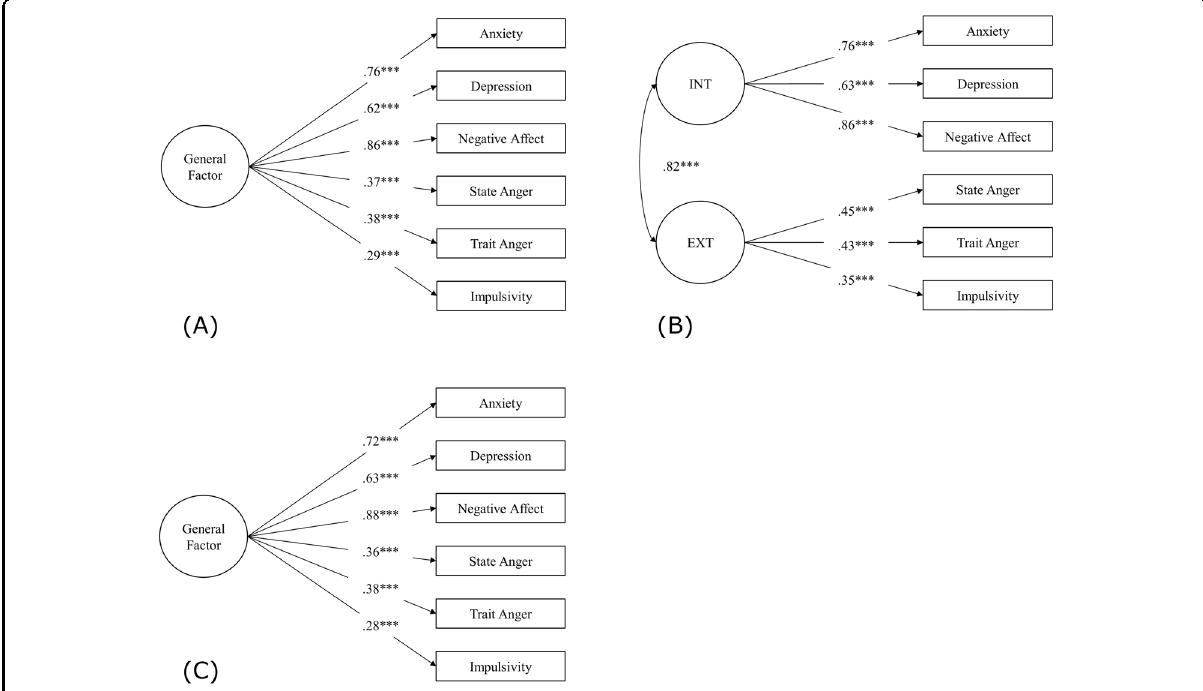
Fig. 2 High correlation between internalizing and externalizing factors suggests a one-factor model of psychopathology among older adults in the Health and Retirement Study. INT internalizing, EXT externalizing. Standardized estimates are shown. A , B Con fi rmatory one-factor (model fi t: χ ²(9) = 70.37, p < 0.001; CFI = 0.980; TLI = 0.967; RMSEA = 0.052, 90% CI [0.041, 0.064]) and two-factor (model fi t: χ ²(8) = 46.71, p < 0.001; CFI = 0.988; TLI = 0.977; RMSEA = 0.044, 90% CI [0.032, 0.056]) phenotypic models in the test sample ( n = 3002). C Con fi rmatory one-factor phenotypic model in the hold-out sample ( n = 3001; model fi t: χ ²(9) = 61.96, p < 0.001; CFI = 0.983; TLI = 0.972; RMSEA = 0.048, 90% CI [0.037,